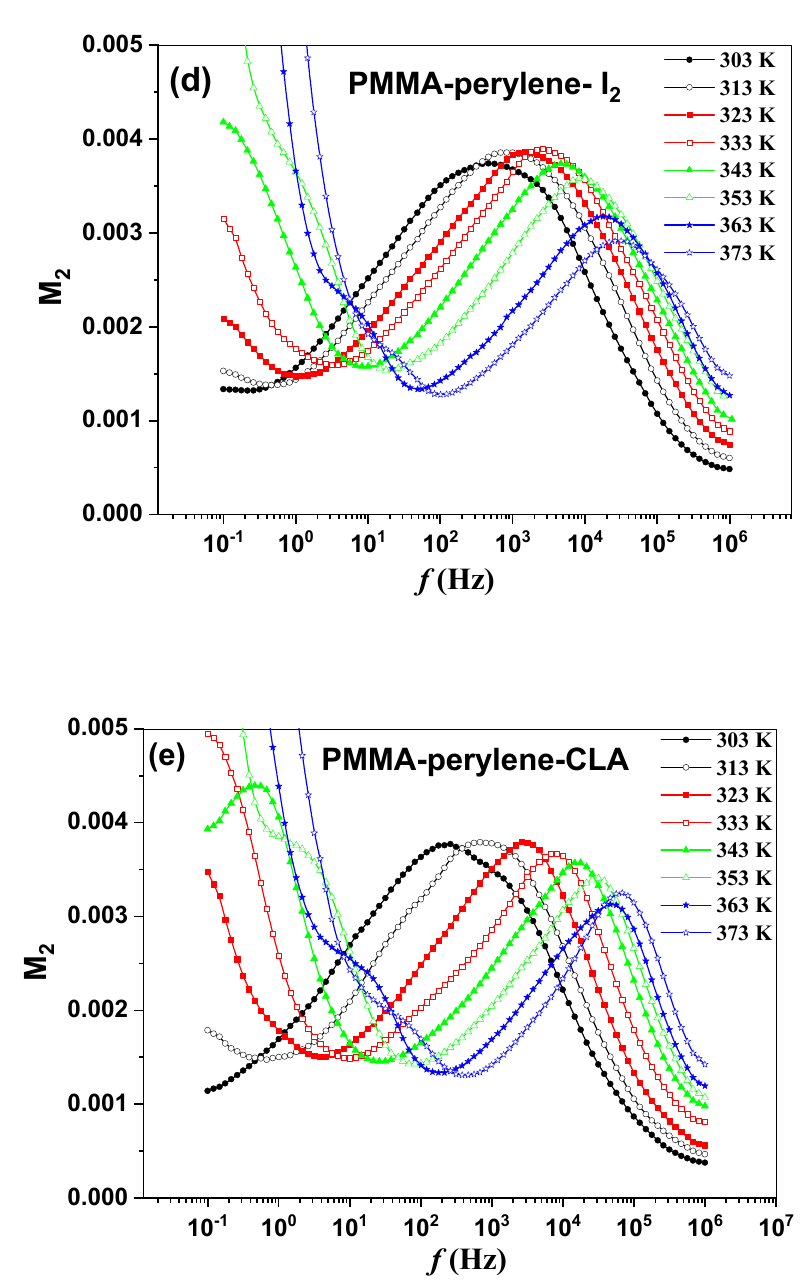
Figure 7. ( a – e ): The frequency dependence of the M 2 of the synthesized polymeric sheets. The characteristic relaxation time for the β -relaxation peak in the synthesized poly- meric sheet has been defined as the reciprocal frequency of the peak maximum ( τ max = 1/ f max ) where f max is the peak frequency of the ε 2 , M 2 and tan δ . The relaxation process in the synthesized polymeric sheets networks can be determined via the Arrhenius equation [37,38]: where f 0 = f max at T → 0, and k is the Boltzmann constant. The transition probabilities between consecutive minimum energy configurations of the dipoles (minima of the po- tential valleys) are related with the activation energy ∆ E a . In this case, as follows from Equation (6), with increasing temperature, the relaxation time decreases exponentially,